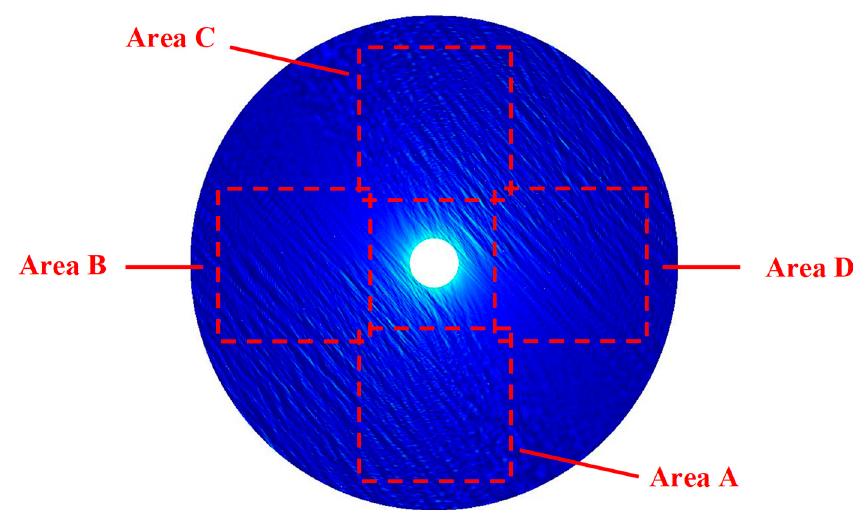
Figure 11. Cropping areas in the original radar image.